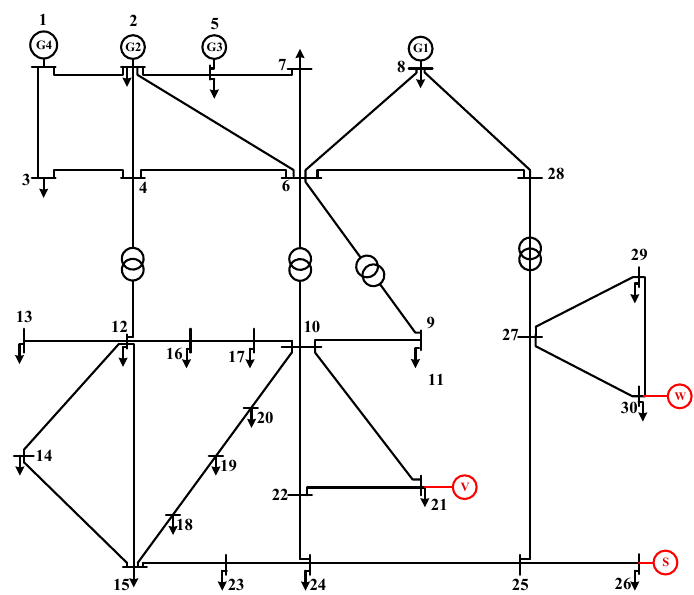
Figure 9. Distributed power and electric vehicle related access methods.